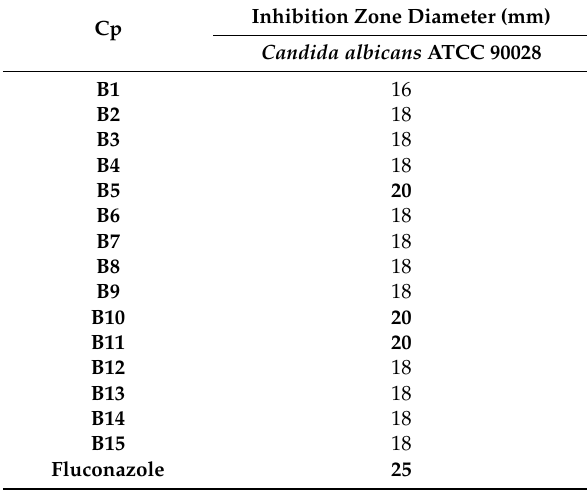
Table 1. The inhibition zone diameters on Candida albicans .